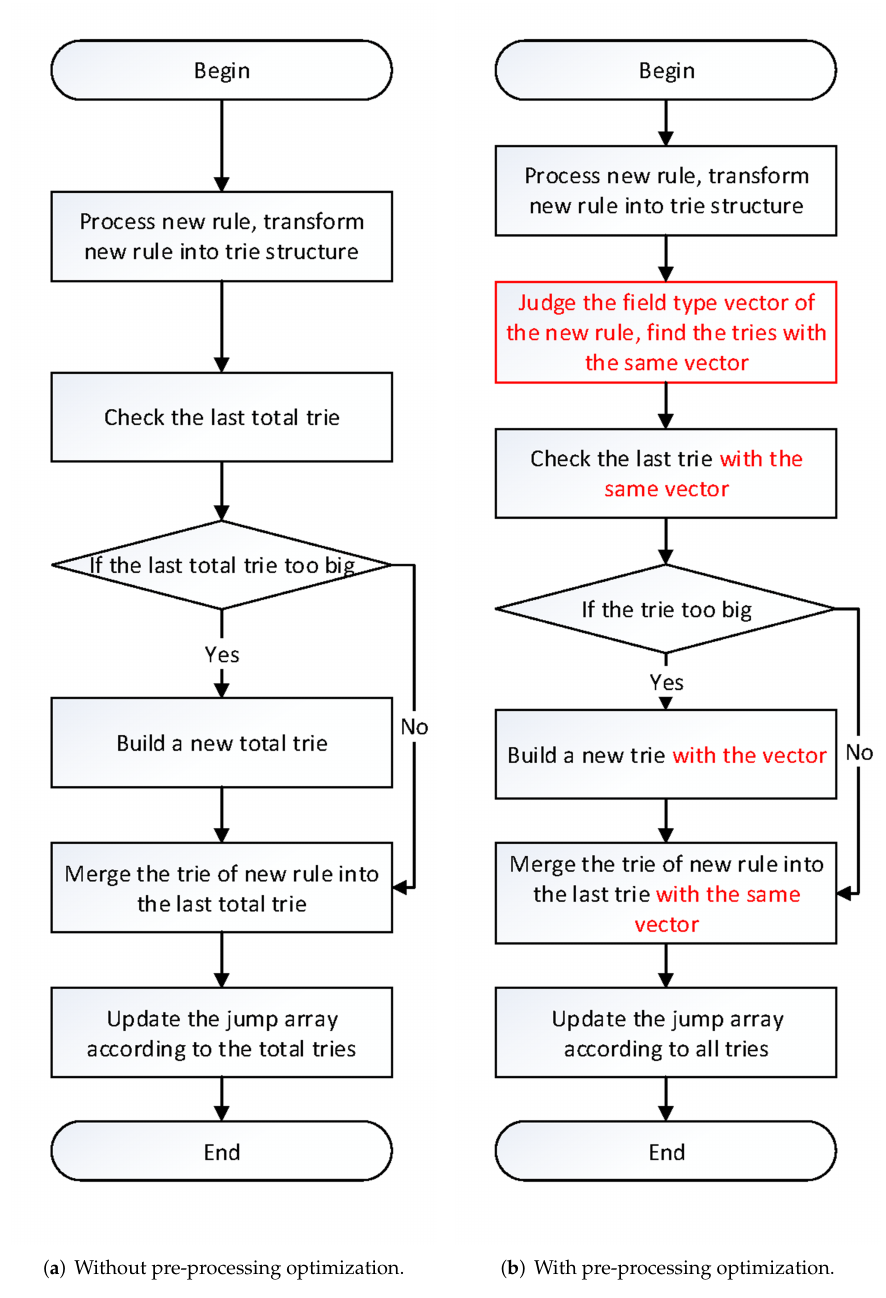
Figure 6. The update process comparison. Algorithm 1: Building process with ruleset